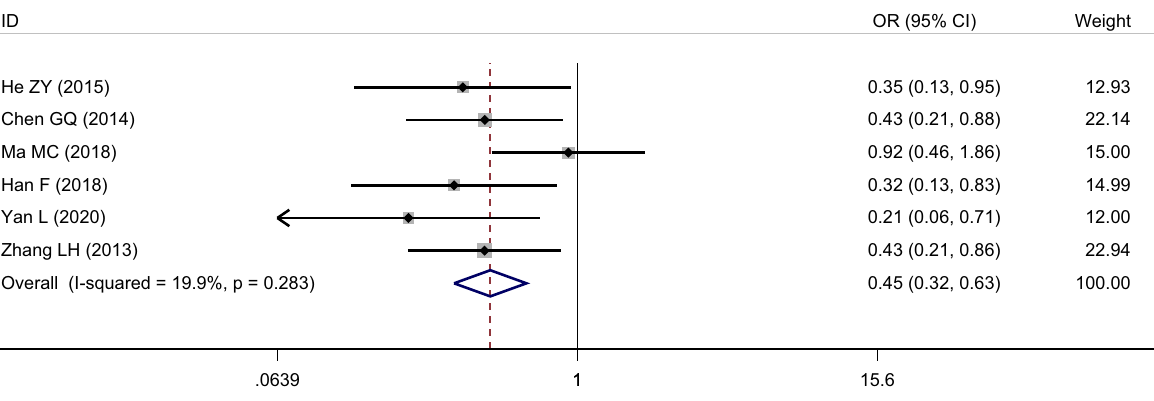
Figure 5: Forest fi gure of relationship between the expression of SIRT1 and the TNM stage of ESCC.